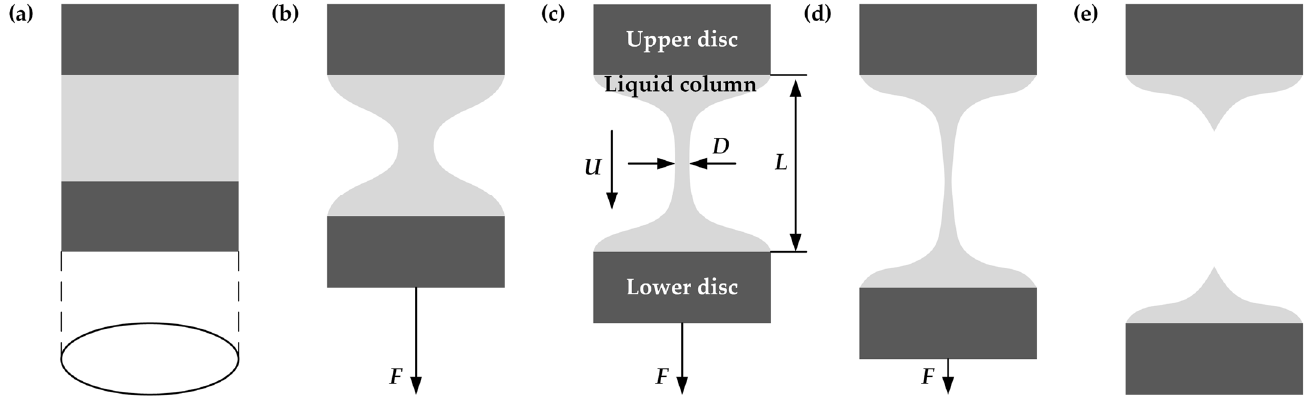
Figure 1. A typical stretching process of PVDF/DMF solution under applied pull force F : ( a ) the cylindrical shape at rest, ( b ) the waist shape at an early stage of stretching, ( c ) typical liquid column during stretching, ( d ) slender filament before breaking off, and ( e ) pinch-off.